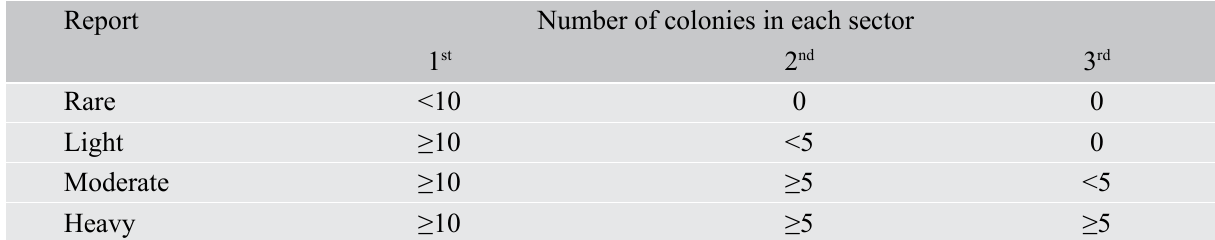
Table I: Semi-quantitative reporting of microbial growth in culture performed in petri-dishes